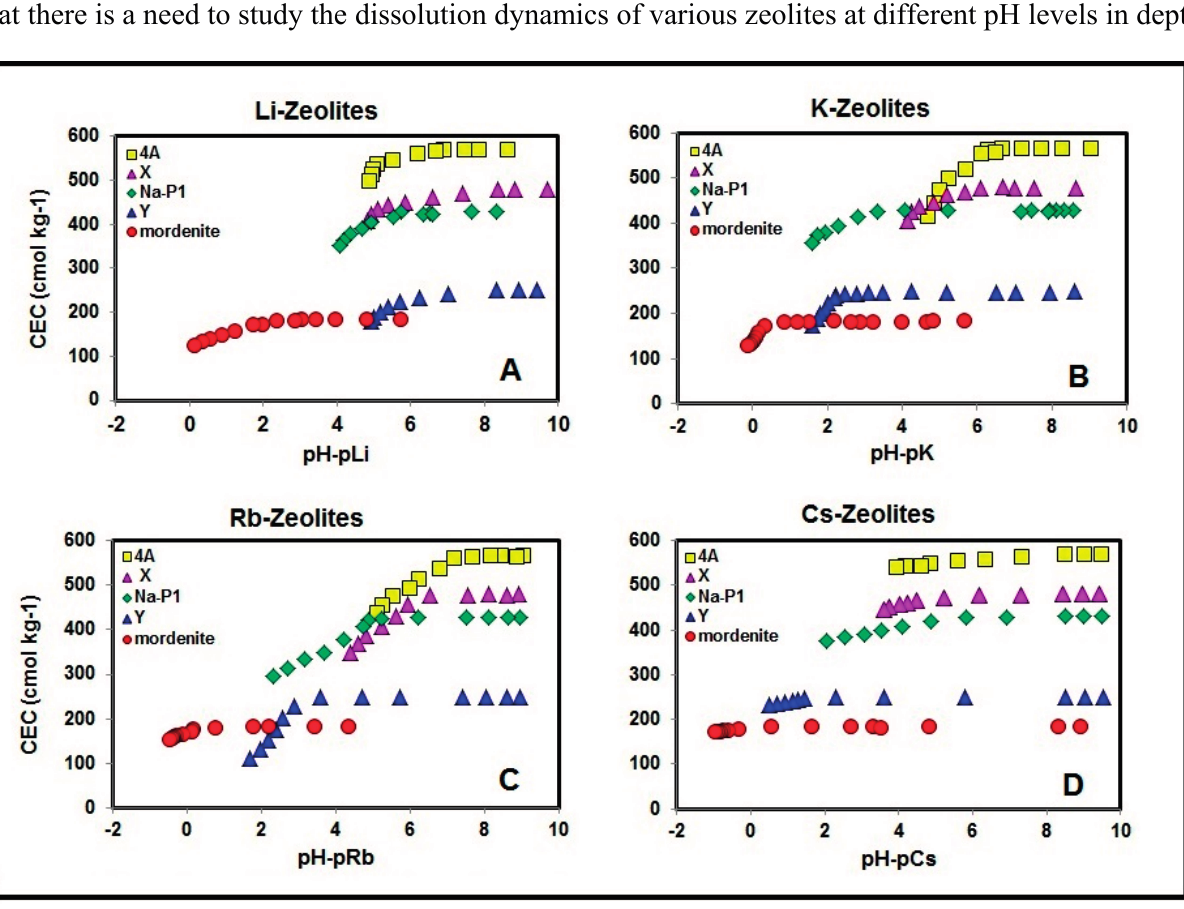
Figure 2. Change in CEC of zeolites with pH-pM. ( A ) Li-zeolites, ( B ) K-zeolites, ( C ) Rb-zeolites, ( D ) Cs-zeolites. cmol in the unit of CEC is